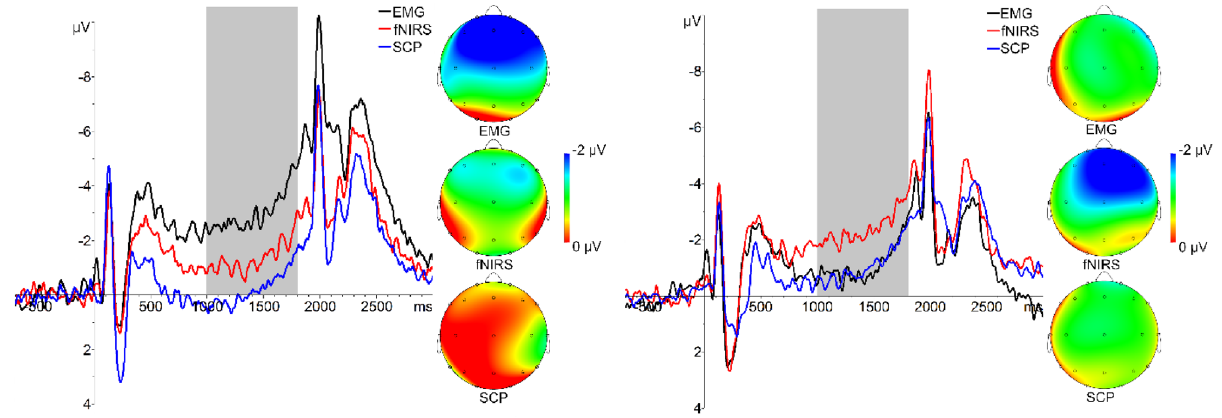
Figure 7. ERP plots at Fz and scalp topographies at time window 1000–1800 ms depicting contingent negative variation (CNV) at pre- and post-assessment in the SCP-, fNIRS- and EMG group. The shaded area indicates the time window in which CNV was measured.